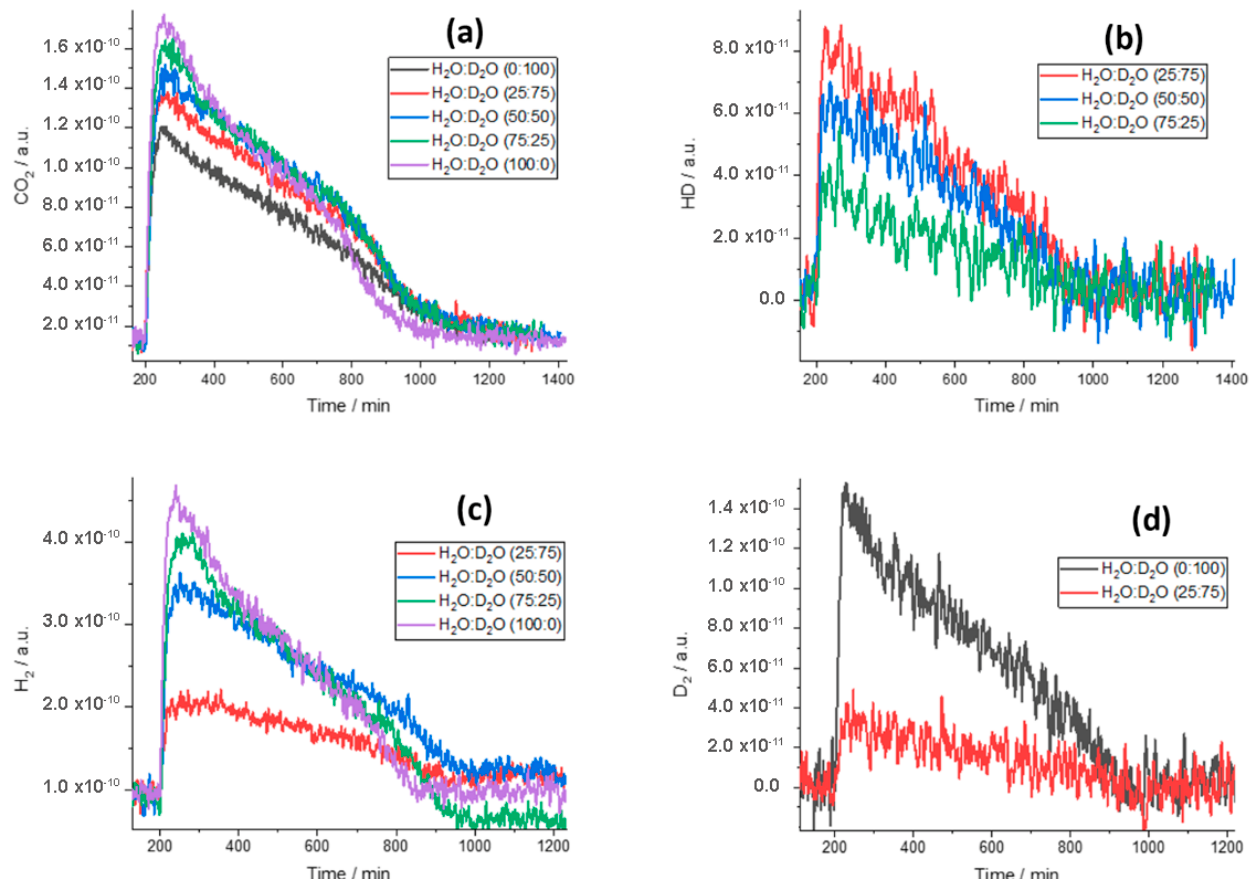
Figure 2. Quadrupole mass spectroscopy (QMS) signals for the evolved CO 2 ( a ), HD ( b ), H 2 ( c ), and D 2 ( d ) formation in different H 2 O/D 2 O mixtures over Pt/TiO 2 during the photocatalytic reforming of oxalic acid. The intensities of the produced gases have arbitrary units since each gas has a special concrete response value.